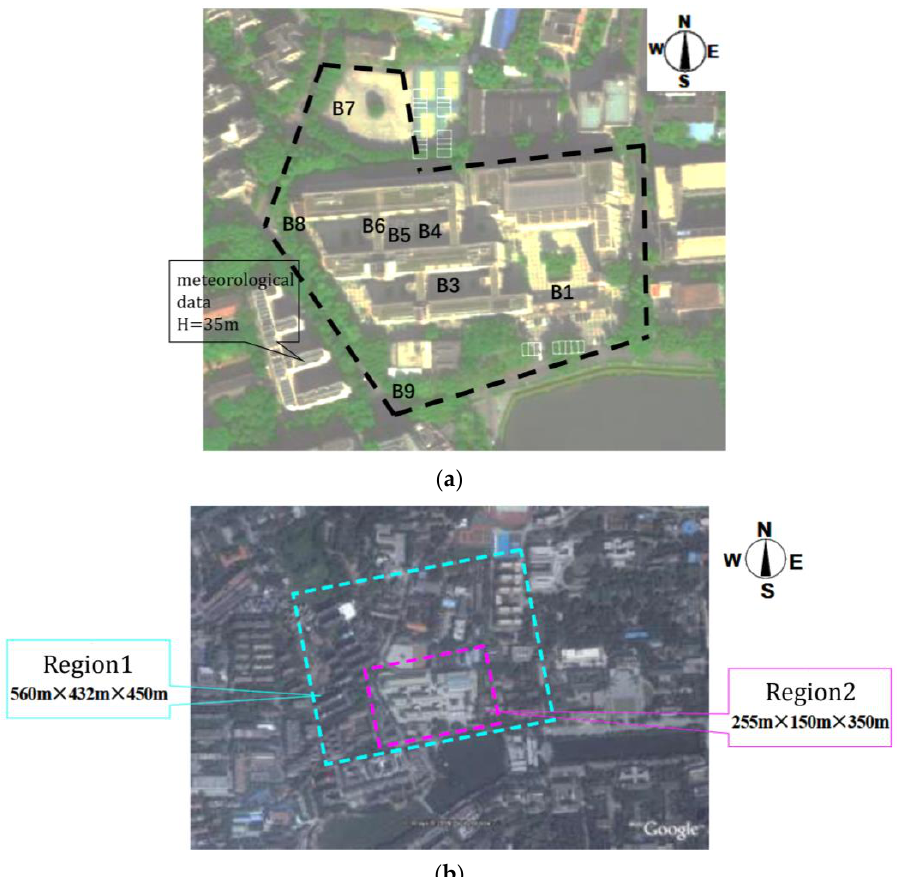
Figure 3. Measuring points and the analytical region. ( a ) The distribution of measuring points during the actual measurement. ( b ) The analytical region in the simulation.